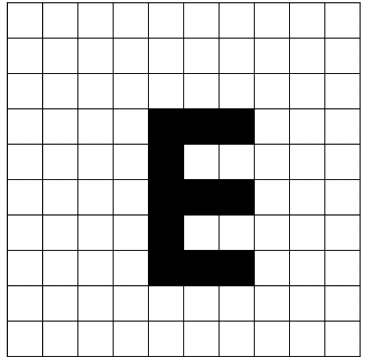
Figure 2. The sample overlapped with the DMD chip. The DMD control area is a 1.5 × 1 mm 2 area, and each speckle has 27 × 18